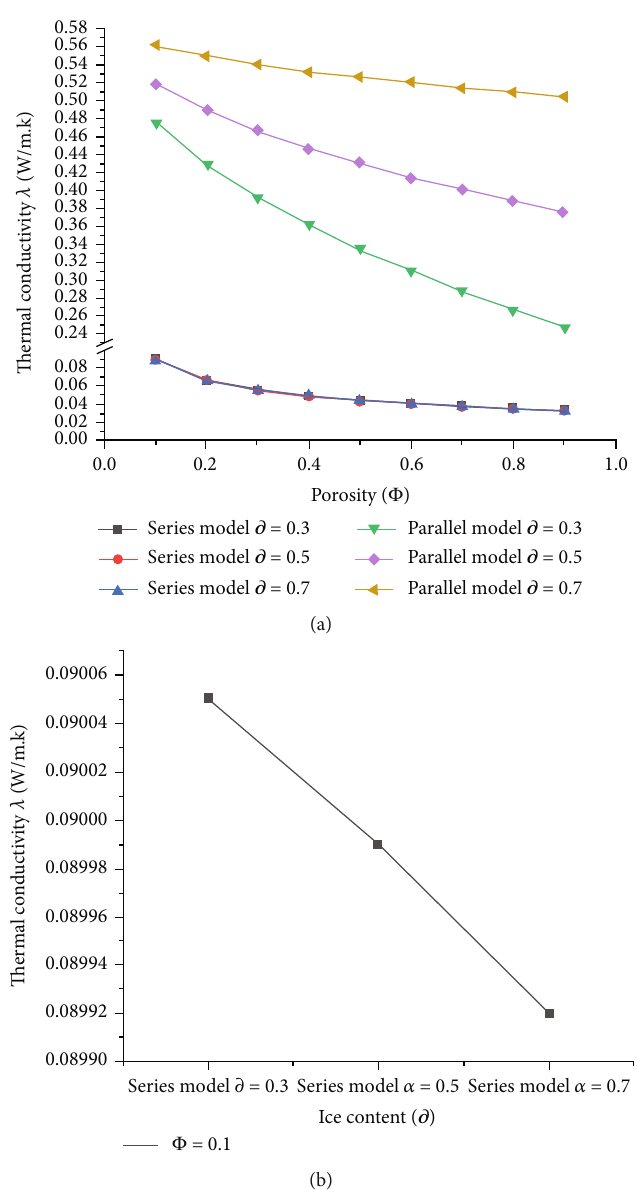
Figure 13: Relationship between thermal conductivity λ and porosity φ of simpli fi ed volume-weighted average REV model with di ff erent ice content ∂